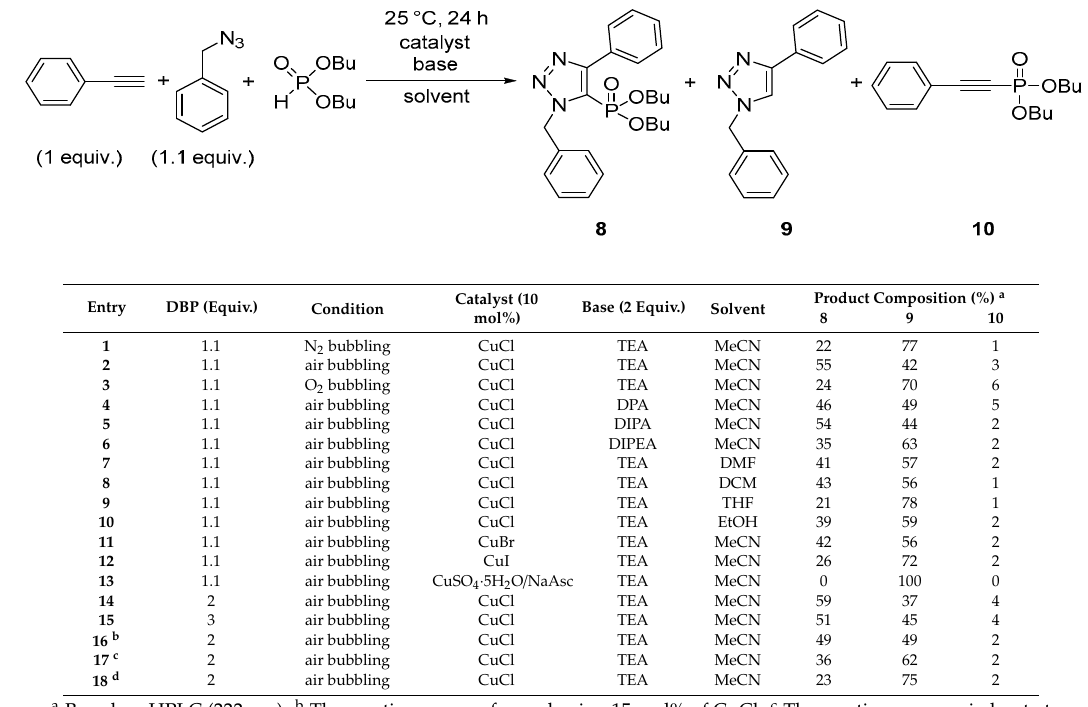
Table 2. Optimization of the domino reaction of phenylacetylene, benzyl azide and dibutyl phosphite.